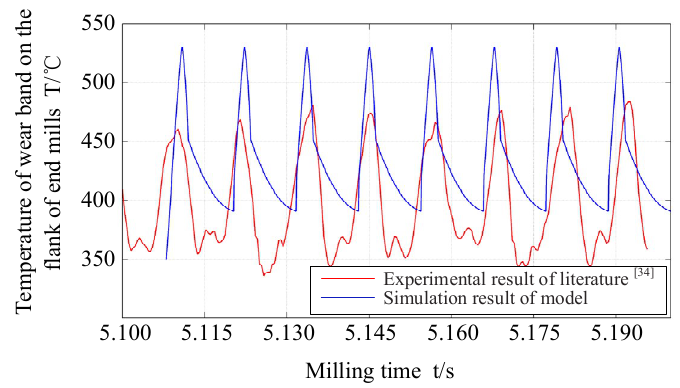
Figure 16. Simulation and experimental comparison of the temperature field model of wear band on = 80 m / min; fz = 0.1 mm / z; Ae = 0.7 mm; and Ap = 16 the flank of end mills ( V = 80 m/min; fz = 0.1 mm/z; Ae = 0.7 mm; and Ap = 16 mm). the flank of end mills ( V